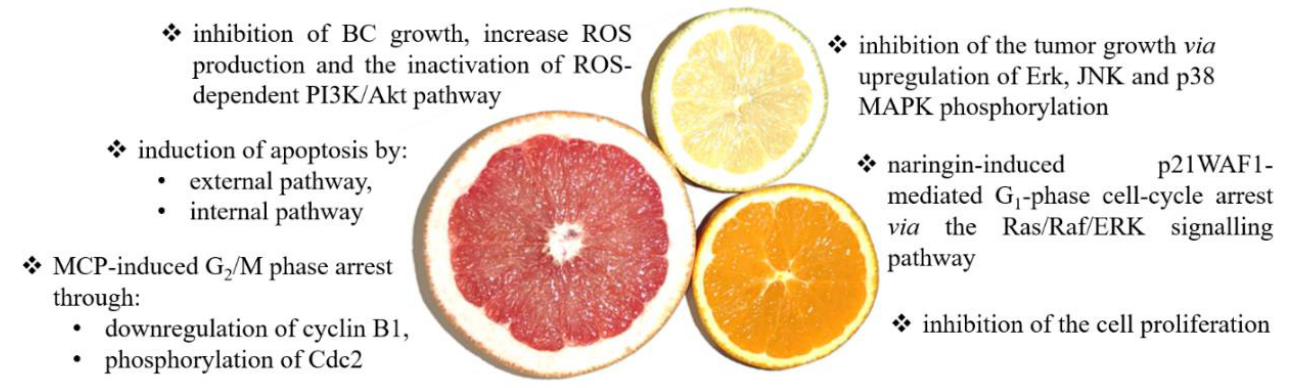
Figure 3. The summary of the anticancer effects and mechanisms of citrus action. Citrus fruit may modulate numerous signaling pathways, including apoptosis [94–100], ROS generation [94], growth and proliferation inhibition [109], and cell cycle